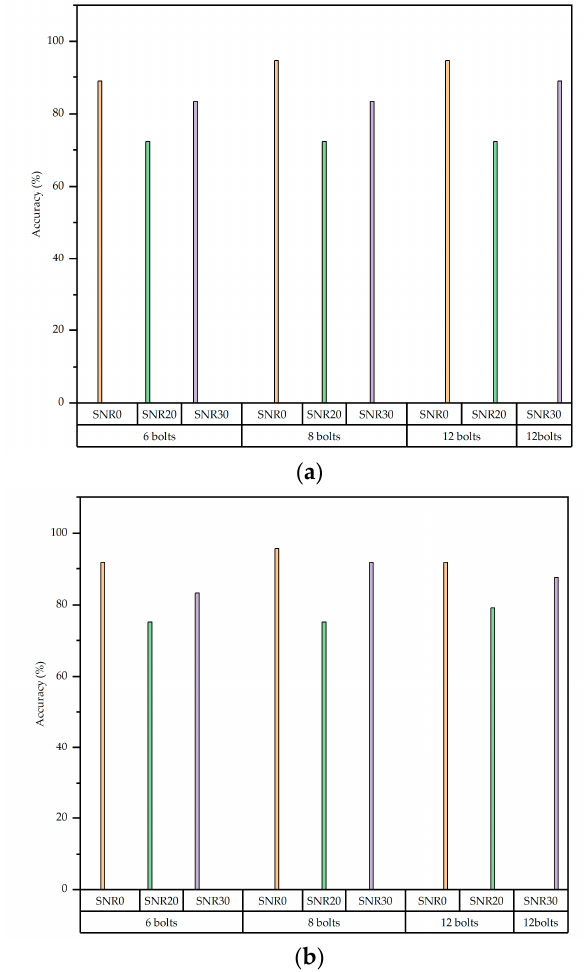
Figure 19. Multi-condition prediction accuracy comparison chart (10% variable amplitude continuous impulse load): ( a ) 70% samples learning; ( b ) 60% samples